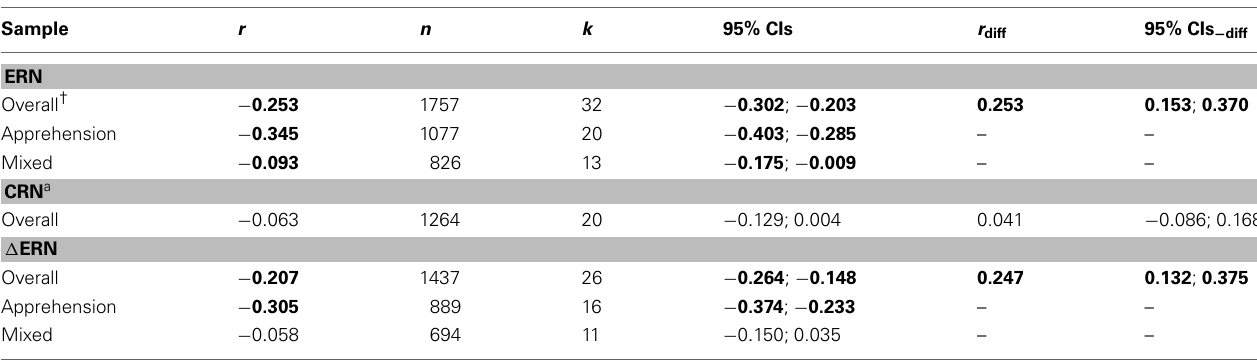
Table 2 | Results from the meta